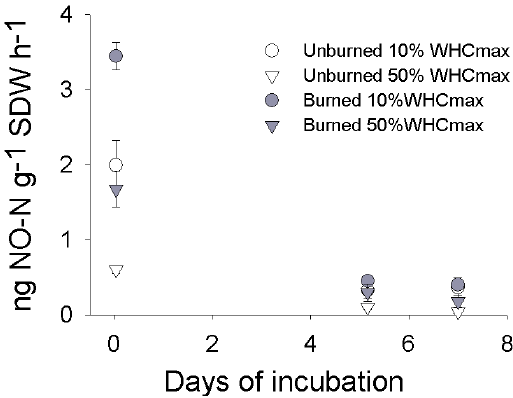
Fig. 9. Emissions of NO (ngNO-Ng − 1 soil dry weight h − 1 ) mea- sured from soil of burned and unburned plots incubated at 10% and 50% of WHC max